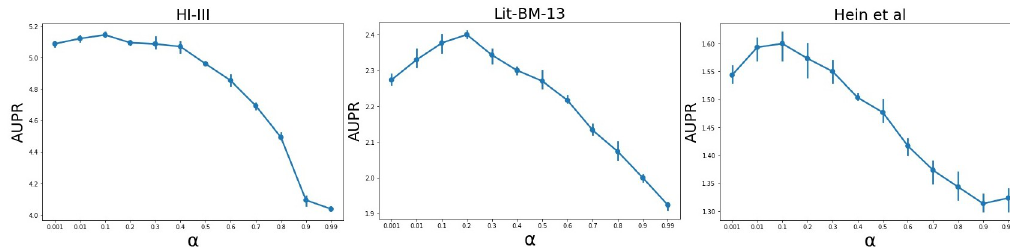
Fig 4. The prediction performance for different values of α on three human PPI